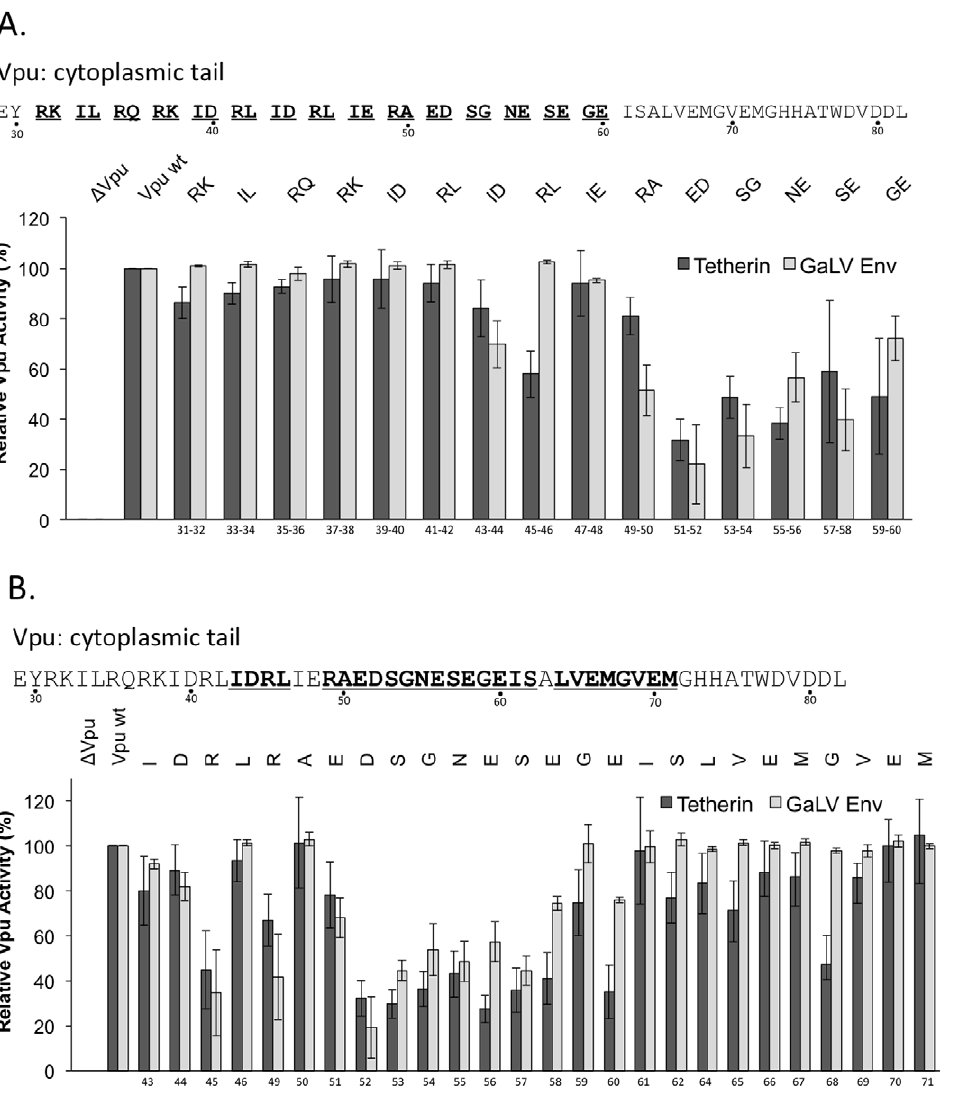
Figure 3. Alanine mutagenic scan of Vpu reveals antagonistic regions for downmodulation of tetherin (dark bars) and GaLV Env (light bars). Amino acids were mutated to alanine, with the exception of alanine, which was mutated to serine (A) A double alanine-mutagenic scan was performed on the cytoplasmic tail region of Vpu (double mutations, underlined). (B) An individual amino acid alanine scan was analyzed for amino acids identified in the double-alanine scan (bold, underlined) and relative Vpu activity was measured. Relative Vpu activity is shown as mean averages (n=3–4, 6 SE) calculated by normalizing infectious units per ml for each mutant Vpu relative to Vpu wildtype (Vpu wt) (100%) and no Vpu ( D Vpu)